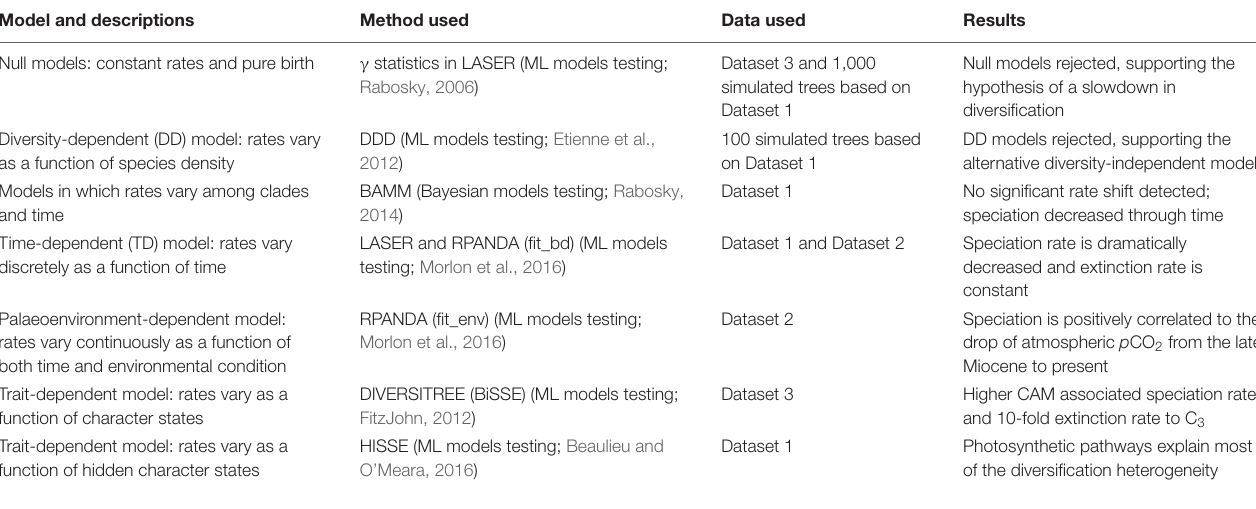
TABLE 1 | Summary of the various diversification models